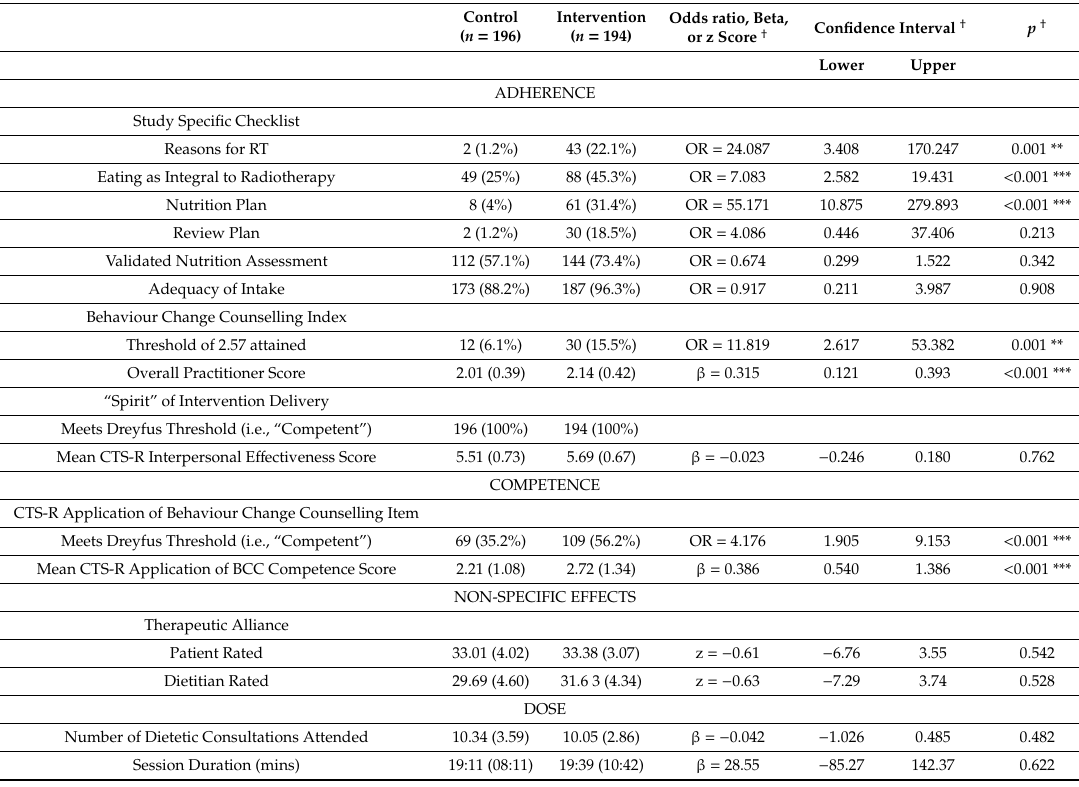
Table 2. Di ff erentiation: Impact of training in the EAT Intervention on dietitian use of study specific checklist items a ; behaviour change counselling b ; attainment of fidelity and competence benchmarks a ; dietitian interpersonal e ff ectiveness and competence b ; non-specific factors b and dose b